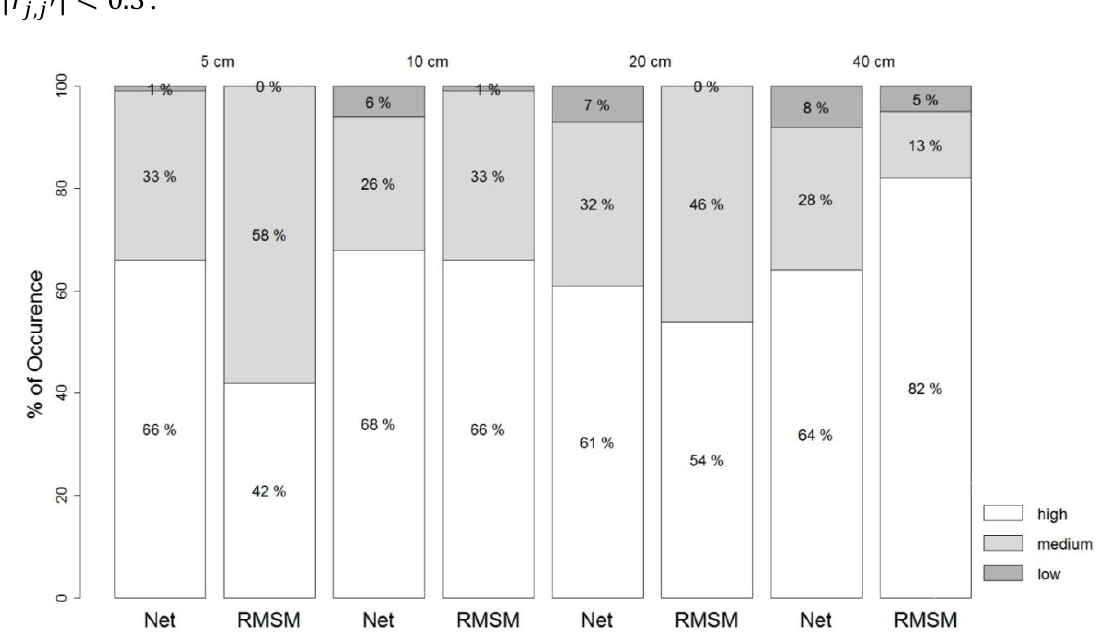
Figure 6. Bar plot showing occurrence (%) for high, medium and low correlation at 5 cm, 10 cm, 20 cm and 40 cm depths. For high correlation , for low correlation